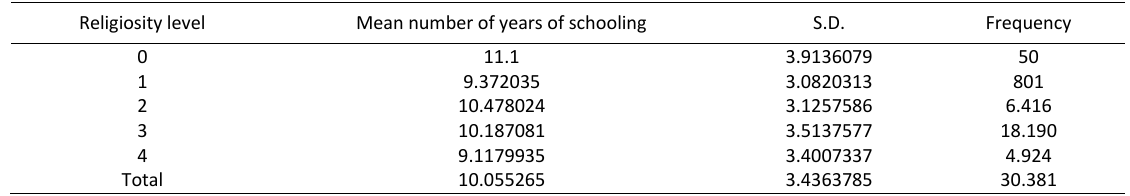
Table 3: The average garbage score by religiosity and years of schooling